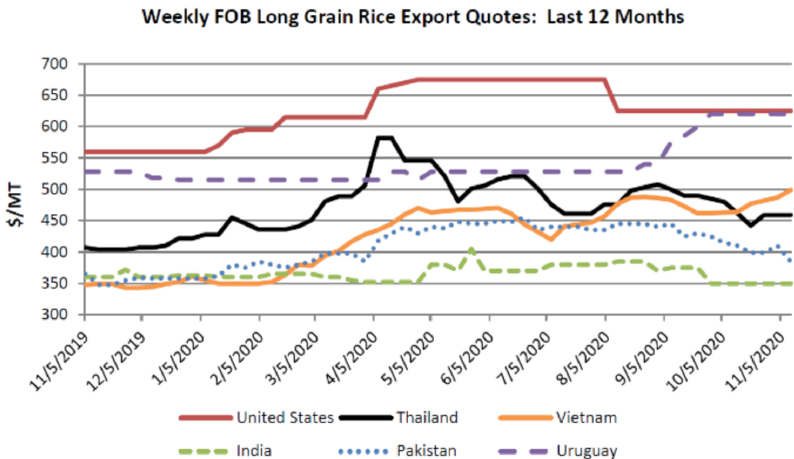
Figure 19. Rice Trading Prices of major rice exporting countries from November 2019 to November 2020. Source USDA: Grain: World Markets and Trade November 2020